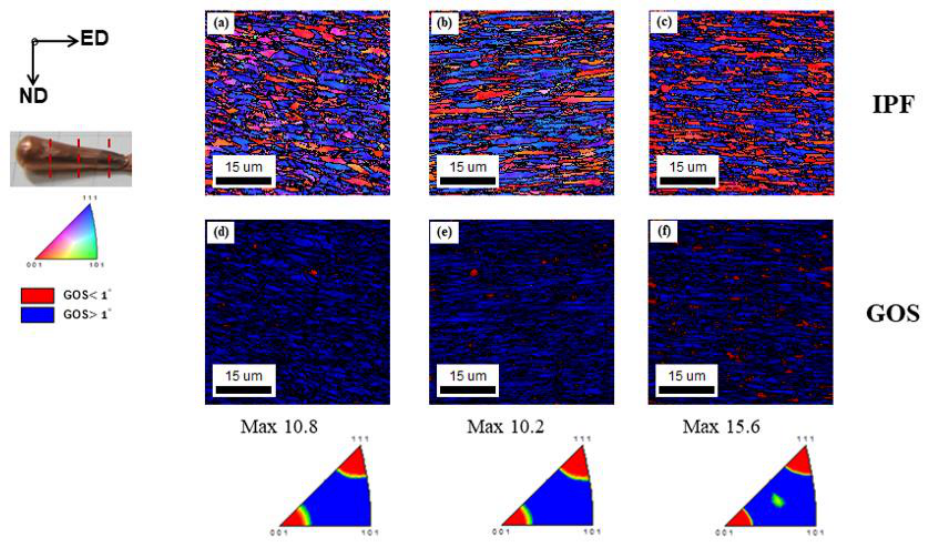
Figure 6. Inverse pole figure (extrusion direction) and GOS maps of FGM Cu at the region of DTE strain level of ( a , d ) 0.5, ( b , e ) 1.0, and ( c , f ) 1.5 in the conical remnant, indicated by red dash lines. The horizontal direction is the DTE direction of the specimen.